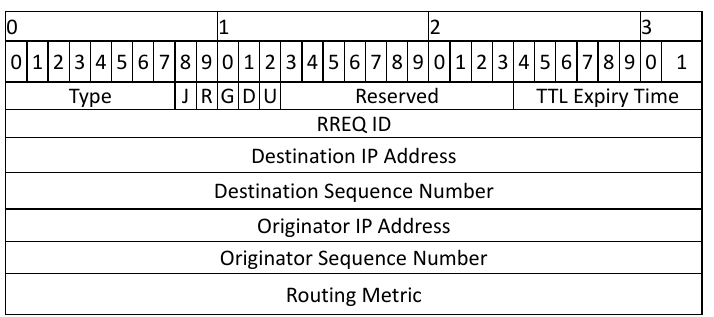
Figure 3. Packet Formats for RREQ.